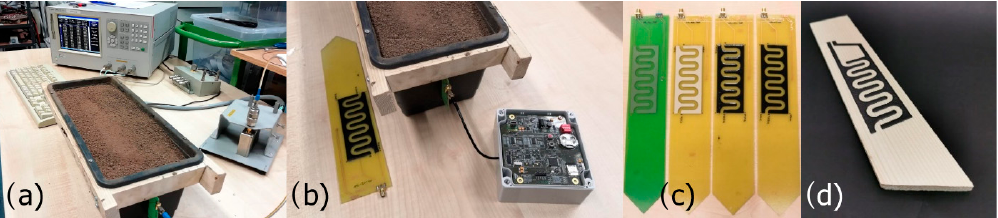
Figure 3. All soil moisture sensors were calibrated using both the ( a ) Agilent 4287A RF LCR Meter and ( b ) the developed Internet of Things (IoT) electronic measuring unit. ( c ) Image of Cu and printed soil moisture sensors, from left: Cu, AGS, CMD, CSP. ( d ) Wood plank-based sensor CMD / plank. The AGS sensor elements were printed using a stencil based on SAATI PES mesh with the mesh count of 120 threads per centimeter (thr. / cm) and the CSP sensor elements were printed with a stencil using SAATI PES mesh with 77 thr. / cm. The sensors were printed on the EKRA E1 printing machine. The snap-o ff was set to 2 mm and flooding and printing speed were 60 mm / s and 100 mm / s, respectively. The thick carbon-based sensor elements (CMD) were printed with the microdispensing technique using the nScrypt printing